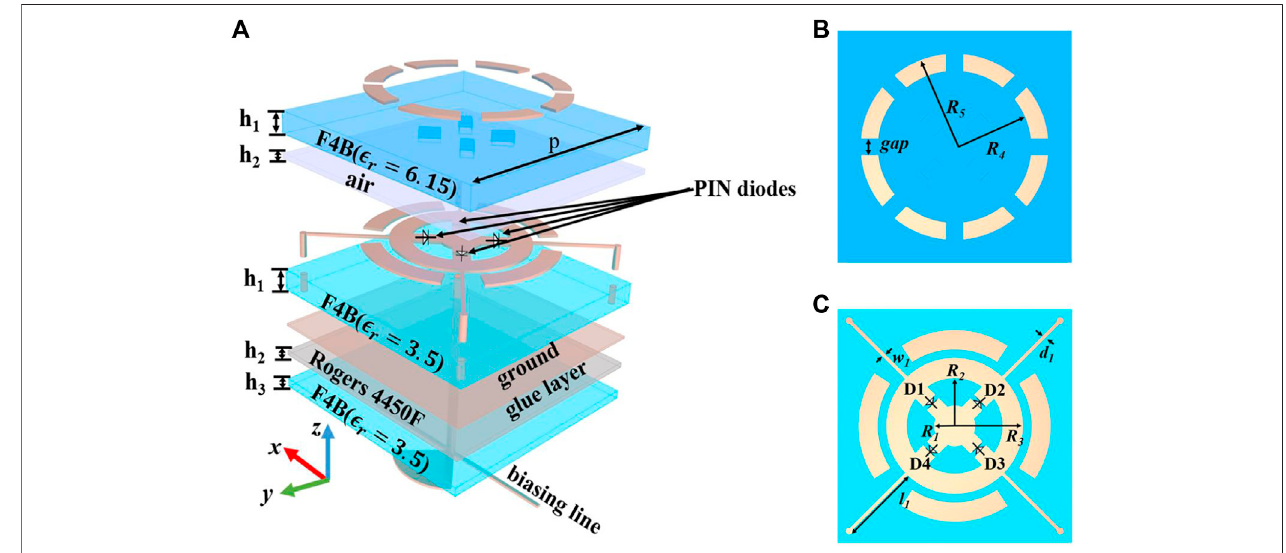
FIGURE 1 | (A) Geometry of the proposed element. (B) First metallic layer. (C) Middle metallic layer.